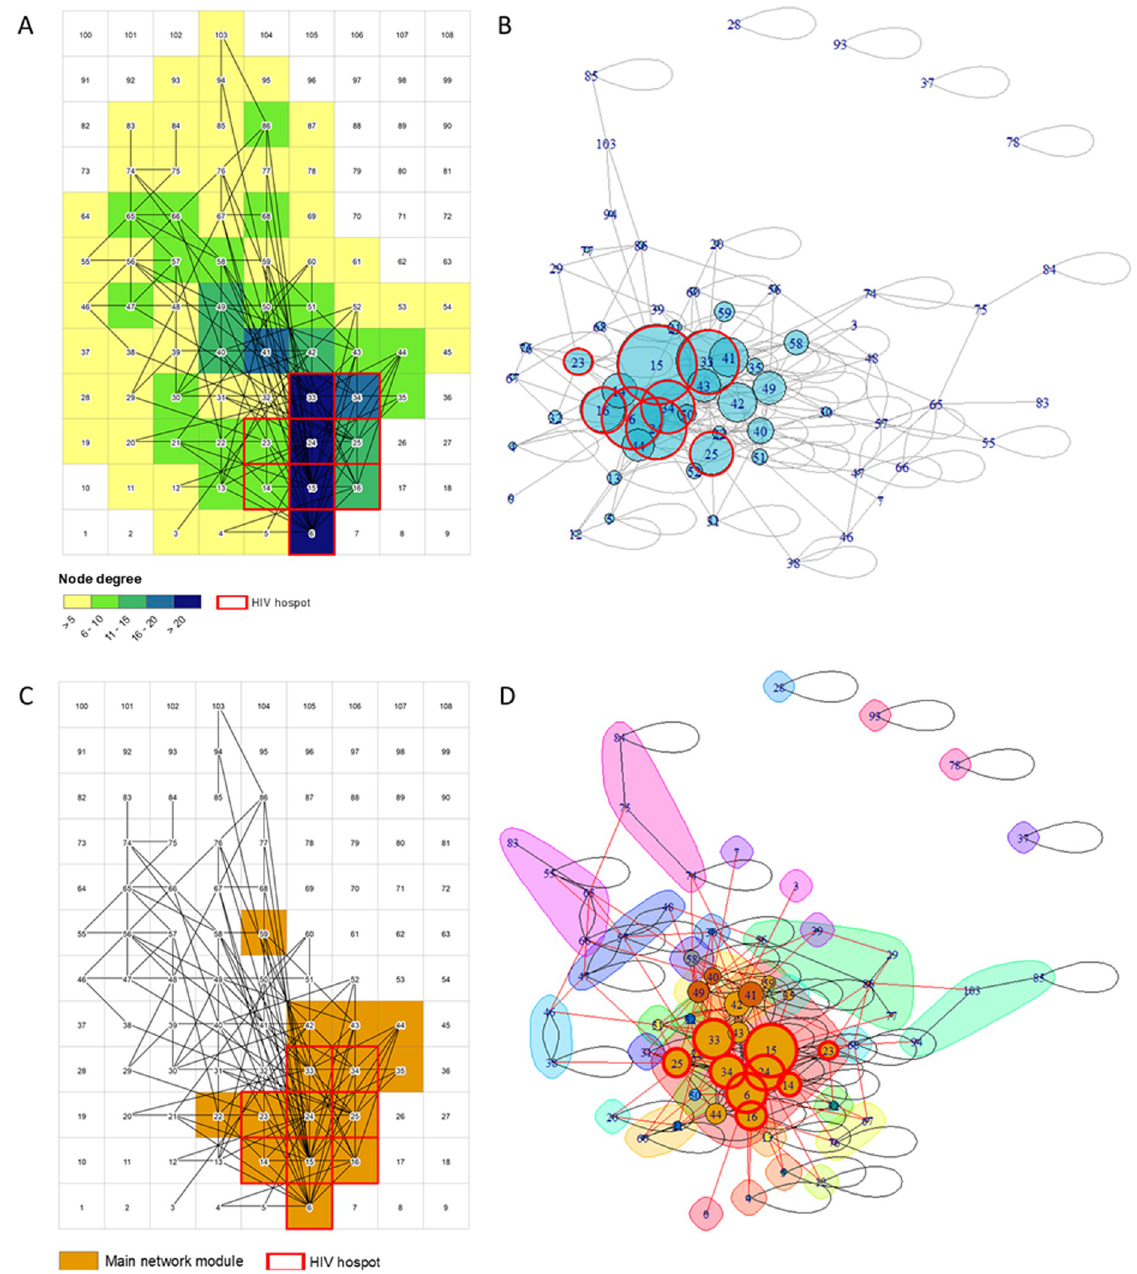
Fig 3. Spatial network configuration of stable sexual partnerships. A) Map illustrating the node degree of each pixel. Nodes with high degree are illustrated in blue, whereas nodes with low degree are illustrated in yellow; B) Eigenvalue estimations for each node. Nodes with highest eigenvalues are centered close to the nodes with their strongest connections. Circles delineated in red indicate the nodes located within the HIV cluster; C) Map illustrating the location of the cells included in the main node community of the network (brown cells); D) Illustrates the different node communities identified in the network. Circles delineated by red illustrate the nodes located within the peri- urban HIV cluster. The numbers in all figures represent the labels of each node in the network.